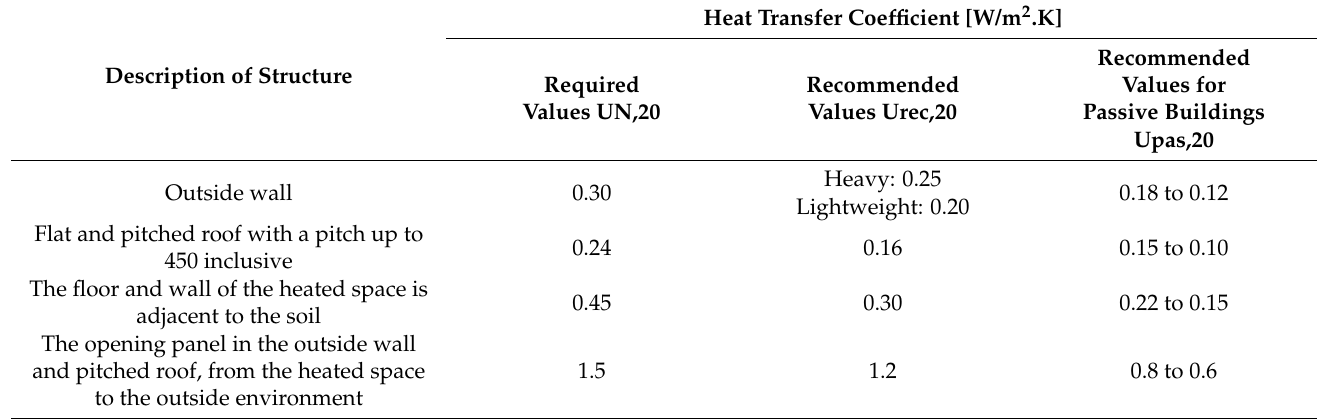
Table 2. Normative Values of the Heat Transfer Coefficient (CSN 73 0540-2: 2011 Thermal protection of buildings–Part 2: